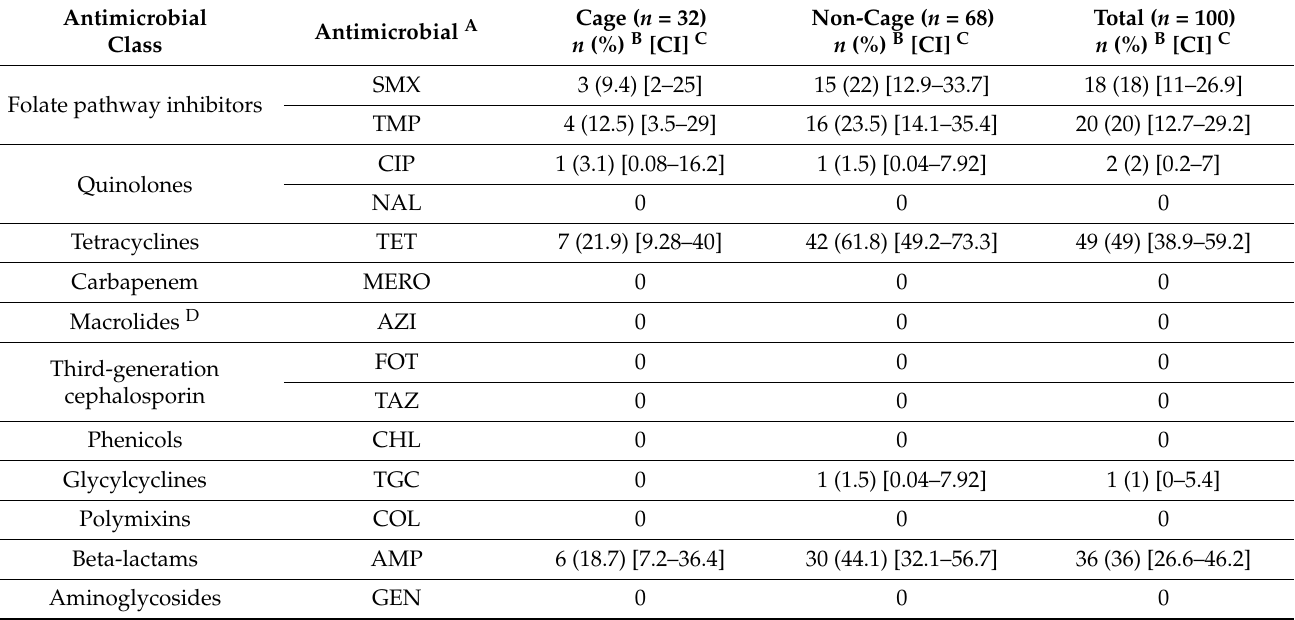
Table 1. Number and percentage of commensal E. coli isolates ( n = 100) from Western Australian retail table eggs of caged and non-caged origin that were resistant to 14 selected antimicrobials.